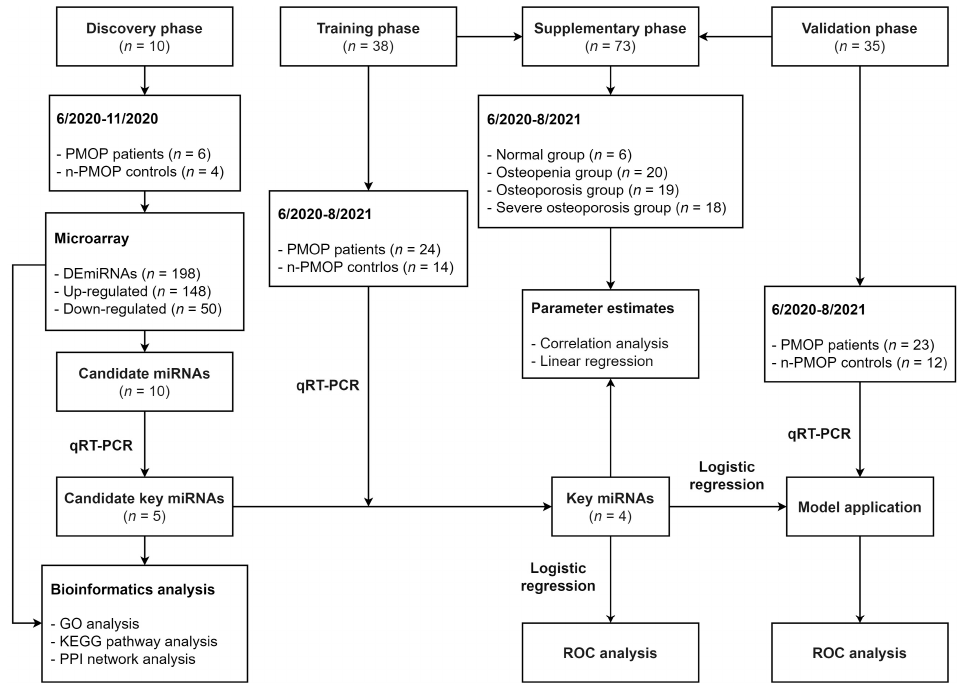
Figure 1. Flowchart of the study. PMOP, postmenopausal osteoporosis; n-PMOP, postmenopausal without osteoporosis; DEmiRNAs, differentially expressed miRNAs; qRT–PCR, quantitative real-time PCR; GO, Gene Ontology; KEGG, Kyoto Encyclopedia of Genes and Genomes; PPI, protein–protein interaction; and ROC, receiver operating